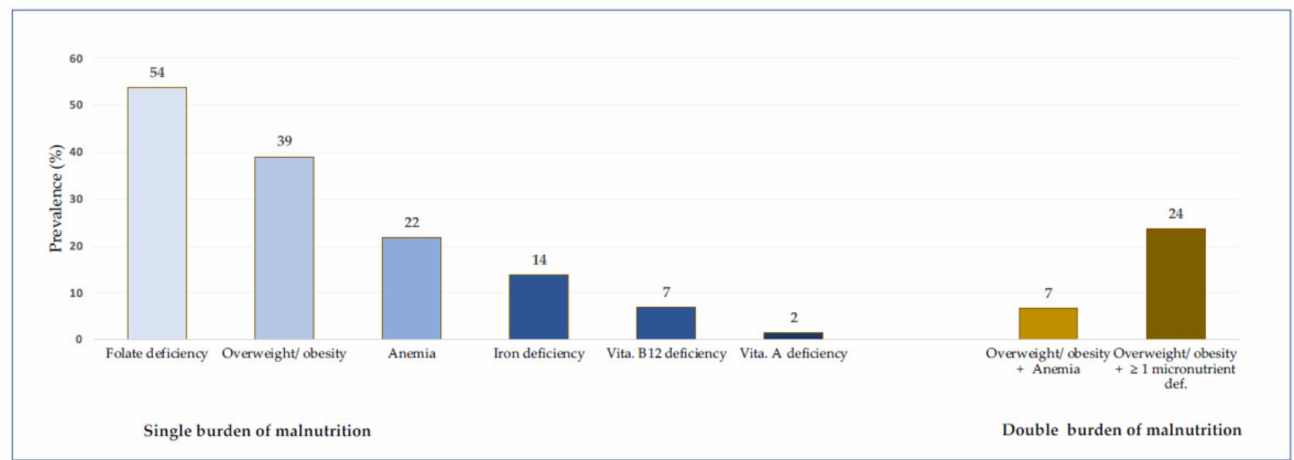
Figure 1. Prevalence of overweight/obesity (OWOB), anemia, micronutrient deficiencies and the co-occurrence of OWOB and anemia (i.e. Overweight/obesity + Anemia) and OWOB and at least a micronutrient deficiency (Overweight/obesity + ≥ 1 micronutrient